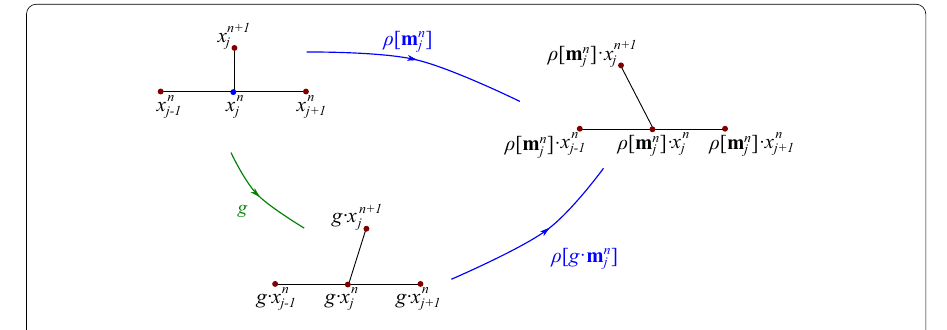
Fig. 23 Equivariance condition applied to the grid